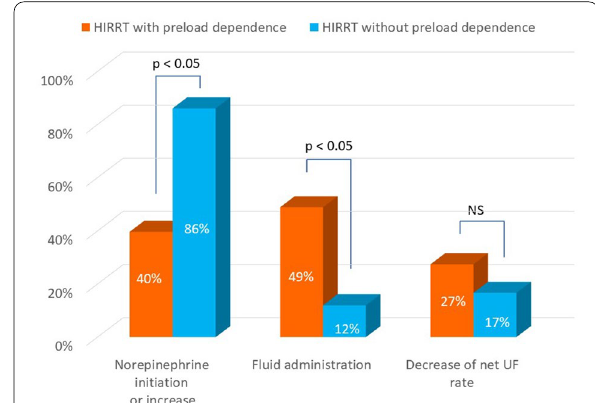
Fig. 4 Therapeutic management of HIRRT. Values per type of HIRRT do not add up to 100% since multiple interventions could be selected by attending physician. HIRRT hemodynamic instability related to renal replacement therapy, NS not significant, UF